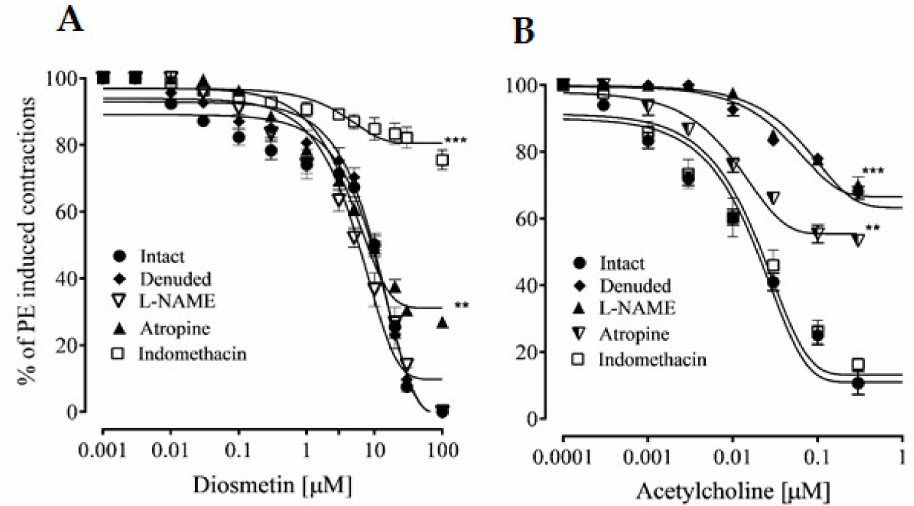
Figure 3. The effects of ( A ) diosmetin and ( B ) acetylcholine (ACh) on contractions that were induced by phenylephrine (PE; 1 µ M) in intact and denuded aortic rings from rats that were pretreated with 10 µ M of L-NAME, 1 µ M of atropine and 1 µ M of indomethacin. The relaxation responses are shown as means ± SEM ( n = 6). Significant differences: ** p < 0.01; *** p <